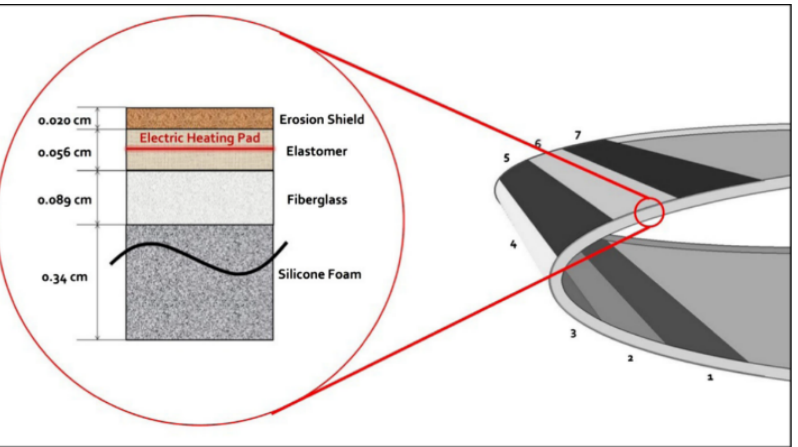
Figure 15. Electro-thermal heating coating built-in four-layer composite panel for de-icing purposes. Reprinted with permission from [83].